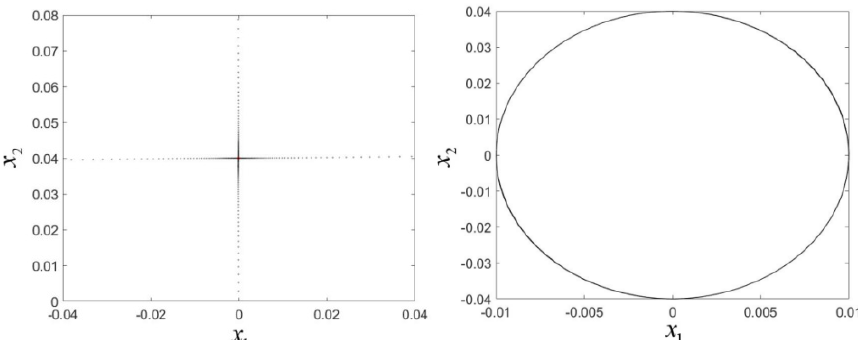
Figure 4. The stable periodic motion in 1:4 resonance when µ = − 0.02: ( left ) the stable fixed point; ( right ) the stable periodic motion.